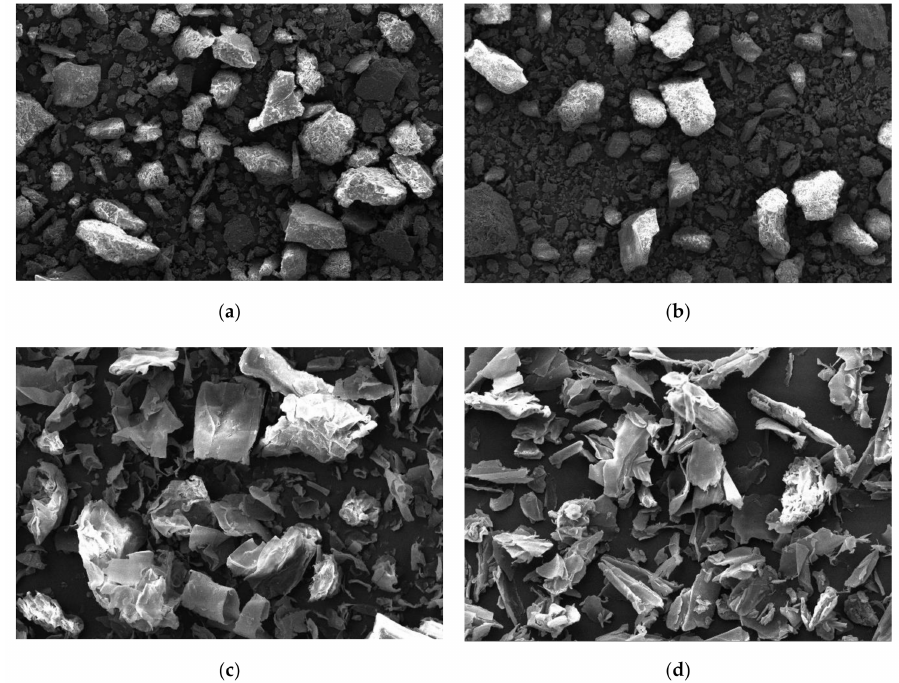
Figure 3. Micro surface texture morphologies of the mineral filler particles. ( a ) Limestone filler; ( b ) granite filler; ( c ) coconut peat filler; ( d ) bagasse filler.